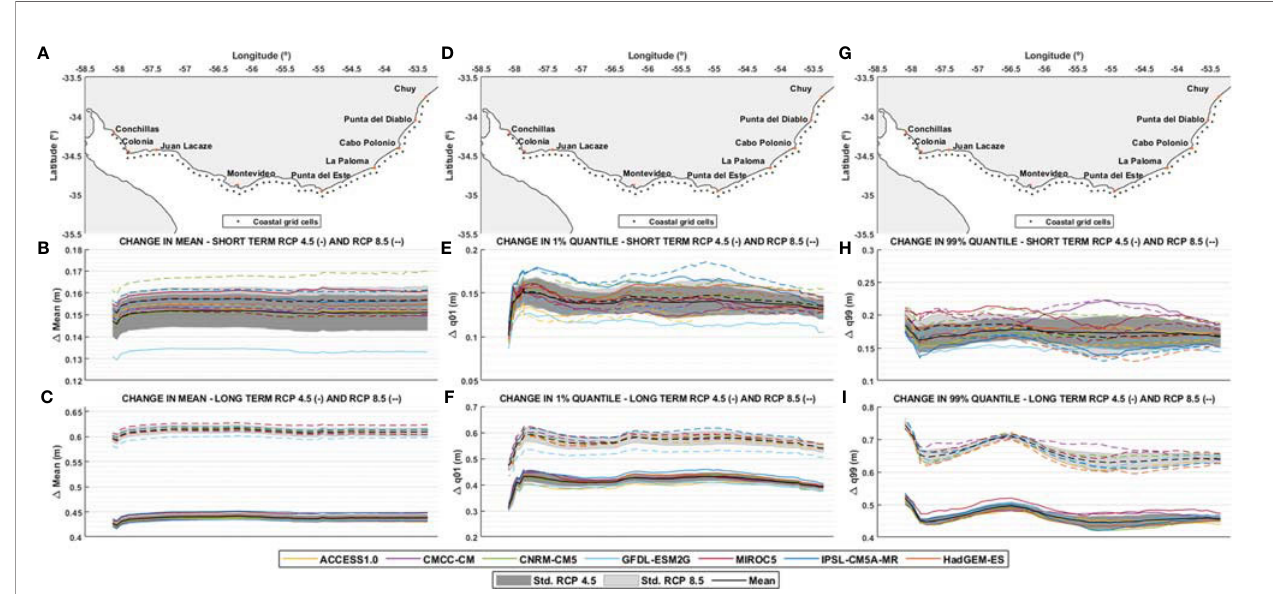
FIGURE 8 | Change in mean (A – C) , change in 1% quantile (D – F) and change in 99% quantile (G – I) of TSL obtained from local model forced with each GCM and ensemble (black), along the coast for short (2026-2045) and long term (2082-2100) and for RCP 4.5 (continuous lines) and RCP 8.5 (dotted lines). E.g.: change in 99% quantile for the short term is calculated as the difference between 2045-2026 99% quantile and 1985-2005 99% quantile. (A, D, G) : coastal grid cells. (B, E, H) : change for short term. (C, F, I) : change for long